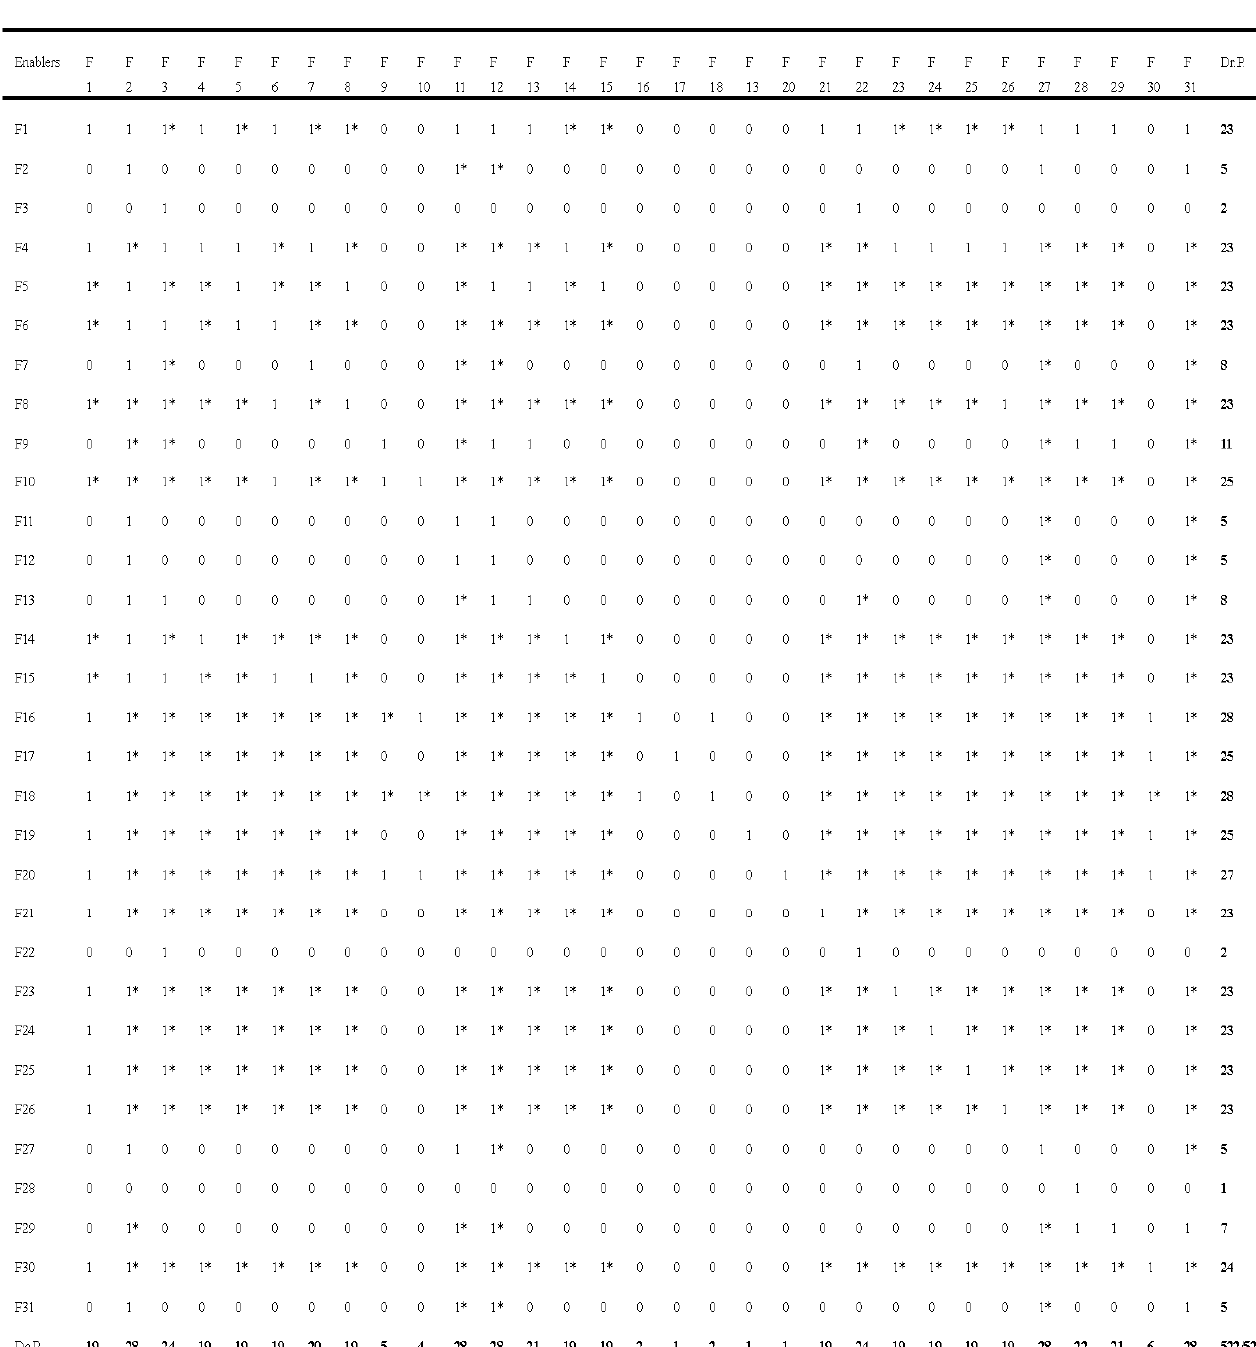
Figure A2. Note: See Table 2 for enabler names; De.P. = Dependence power; Dr.P. = Driving power; Figure A2. Reachability matrix of enablers. Note: See Table 2 for enabler names; De.P. = Dependence * = Incorporating the “rule of transitivity”. power; Dr.P. = Driving power; * = Incorporating the “rule of